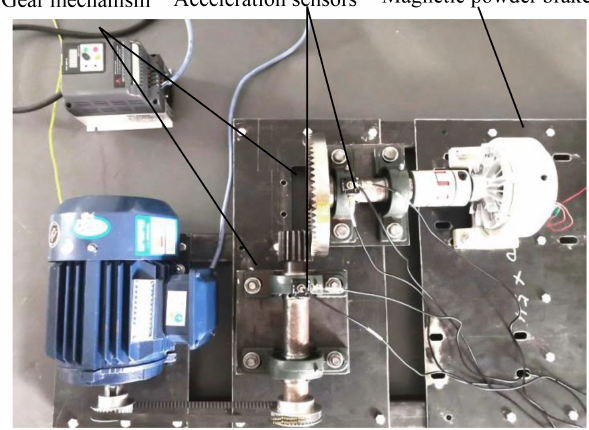
Figure 16. Vibration test platform of the NFG.